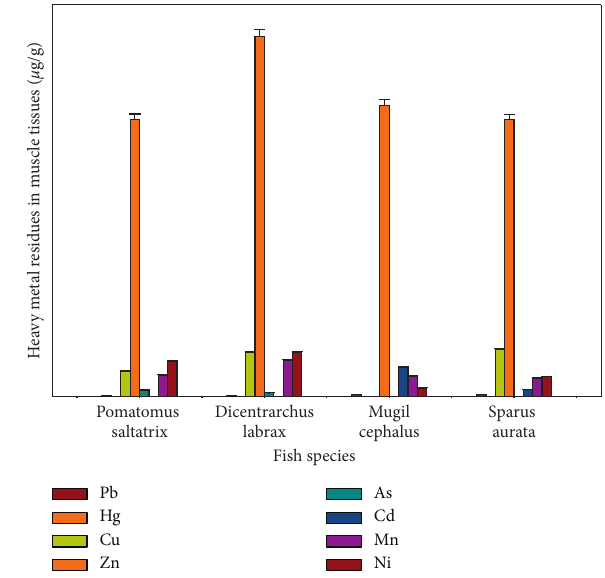
Figure 6: Concentration of Pb, Hg, Cu, Zn, As, Cd, Mn, and Ni residues ( μ g/g) in muscle tissues of fish samples from Izmir, Aegean Sea.